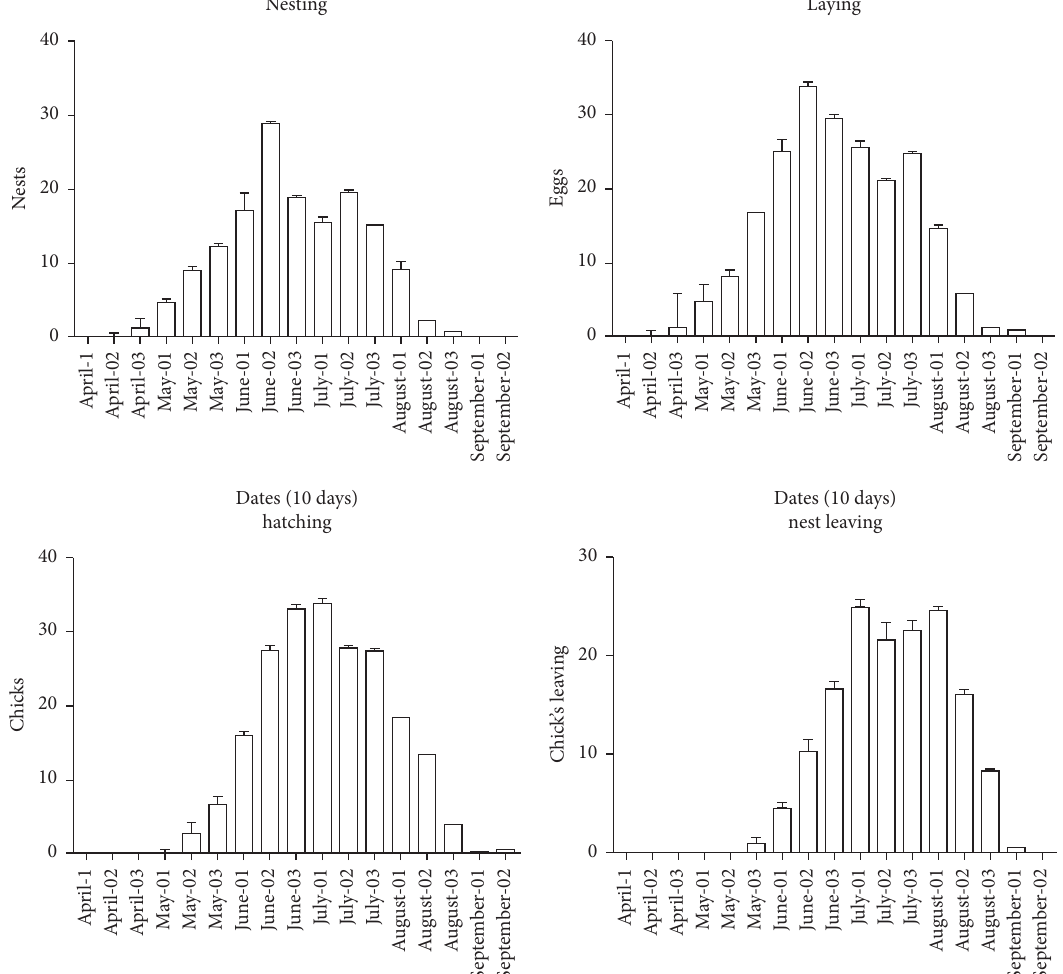
Figure 2: Breeding chronology of turtle dove at Midelt between 2015 and 2018. (nesting: mean ± SD number of nests by decades (10 days) from April to September; laying: mean ± SD number of laid eggs by decades (10 days) from April to September; hatching: mean ± SD number of hatched chicks by decades (10 days) from April to September; nest leaving: mean ± SD number of chicks that survived by decades (10 days) from April to